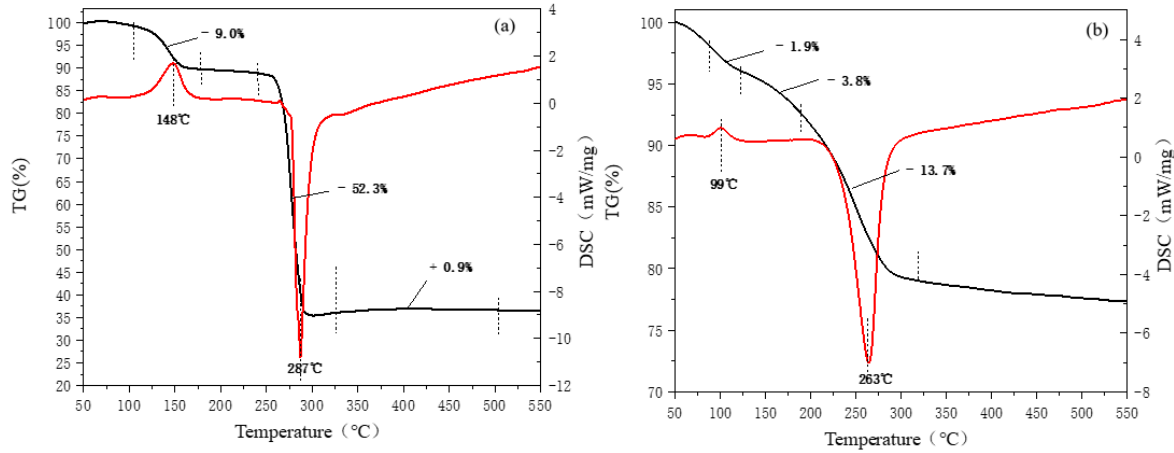
Figure 1. TG/DSC curves of Cu (OAC) 2 ·H 2 O ( a ) and 20%Cu-A-BM ( b ).